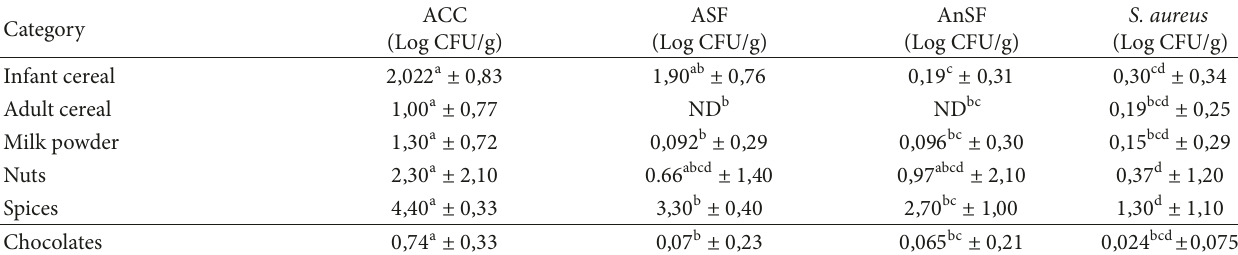
Table 2: Microbiological quality of low 𝑎 𝑤 activity food presented in means of ACC, ASF, AnSF, and S. aureus (Log CFU/g) collected at household